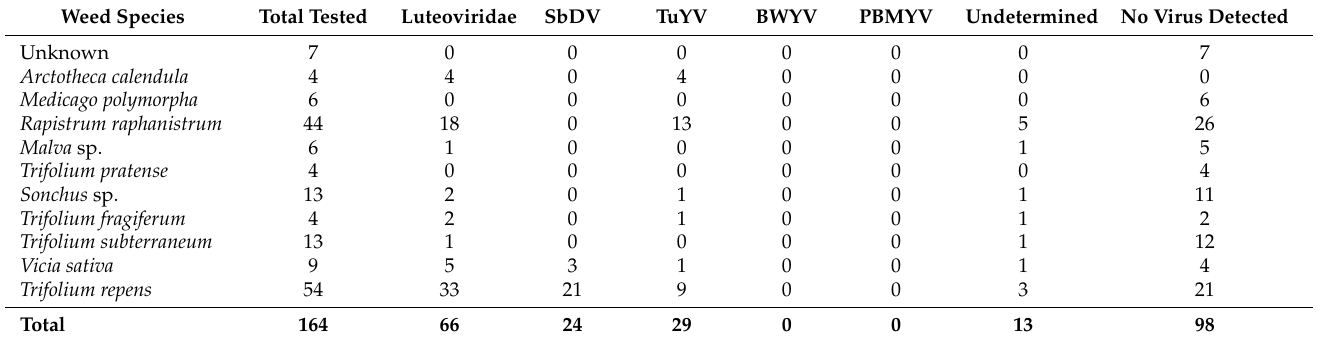
Table 3. Prevalence of virus infections ( Luteoviridae universal primers and species-specific primers) in weed species neighbouring pea crops.